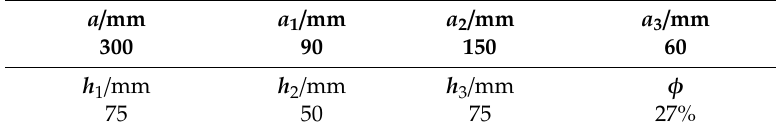
Table 2. Geometric parameters of the plate.